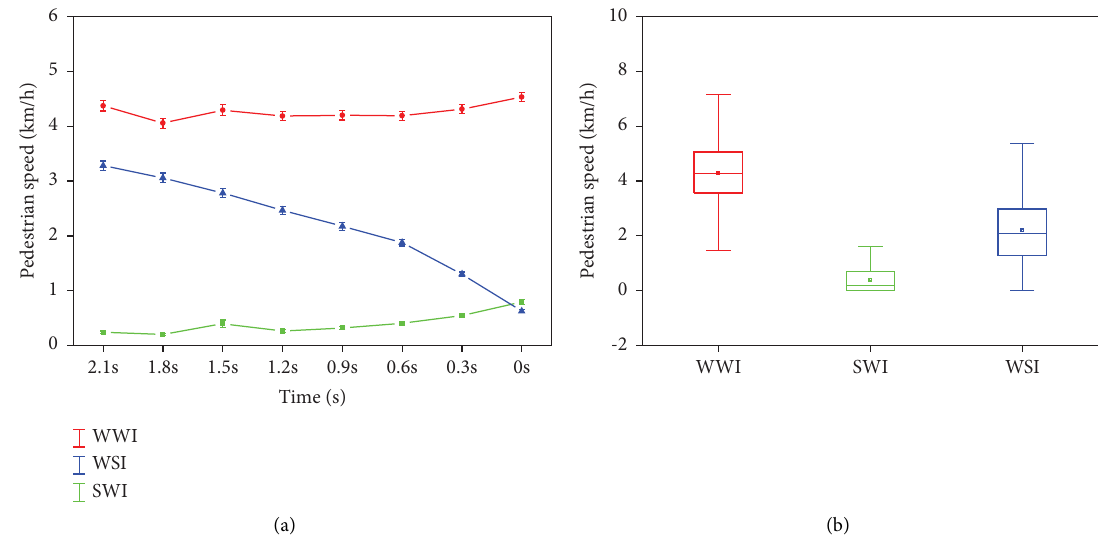
Figure 11: Pedestrian speed under diferent crossing intentions. (a) Line chart of pedestrian speed change with time under diferent intentions. (b) Box diagram of pedestrian speed under diferent crossing